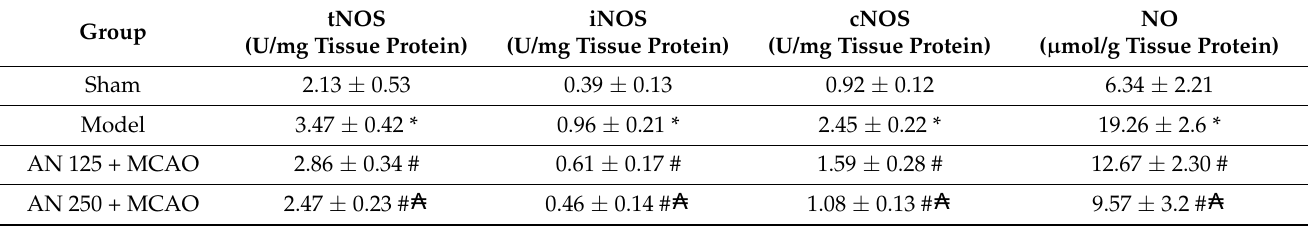
Table 2. The impact of pretreatment with anethole (AN, 125, 250 mg/kg, orally) for two weeks in MCAO-induced cerebral ischemia/reperfusion in rats on the levels of total-, induced- and constitutive nitric oxide synthase and the content of nitric oxide in brain tissues of rats with middle cerebral artery occlusion.